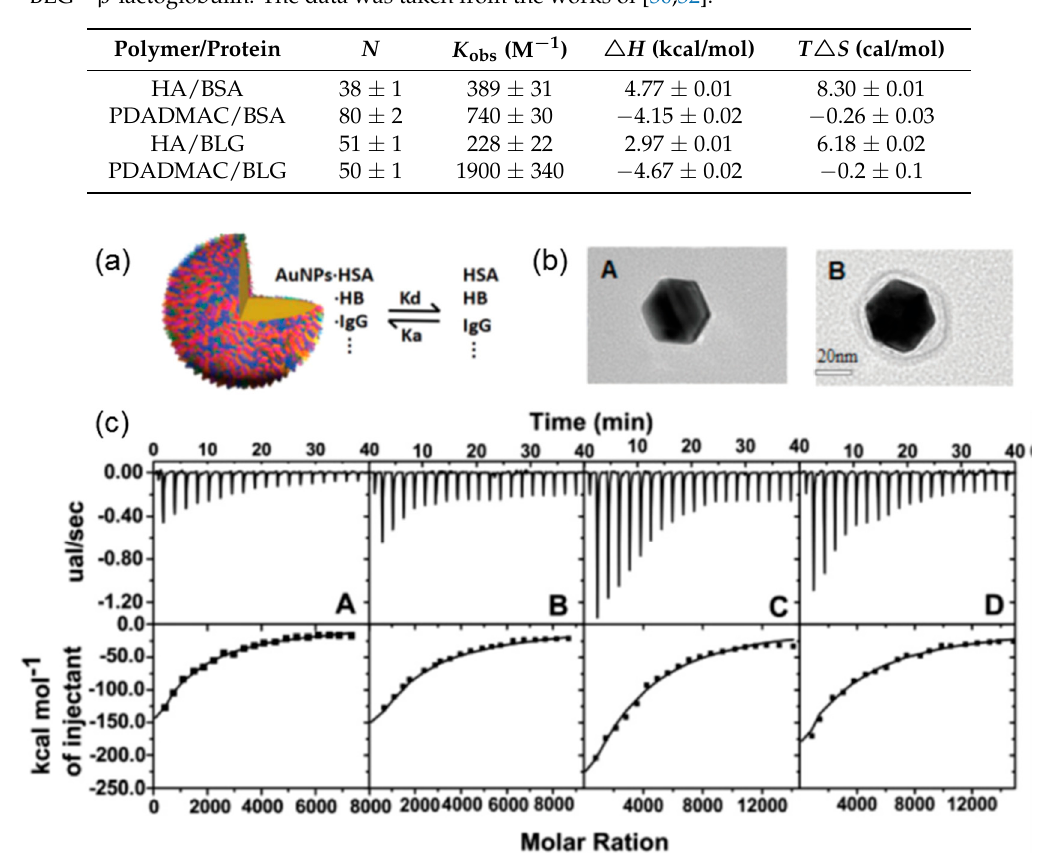
Figure 4. ( a ) The schematic representation of plasma proteins’ adsorption and dissociation on an AuNP ( b ). The typical TEM image of a single AuNP (left) and its complex with plasma protein (right) ( c ). AuNP size dependence of ITC titration with plasma protein at 18 °C. From left to right, the average size of AuNP increased from 15 nm to 25 nm, 40 nm, and 70 nm. Figure 4 was taken and modified from the work of [54]. HAS—human serum albumin; HB—hemo-globin.